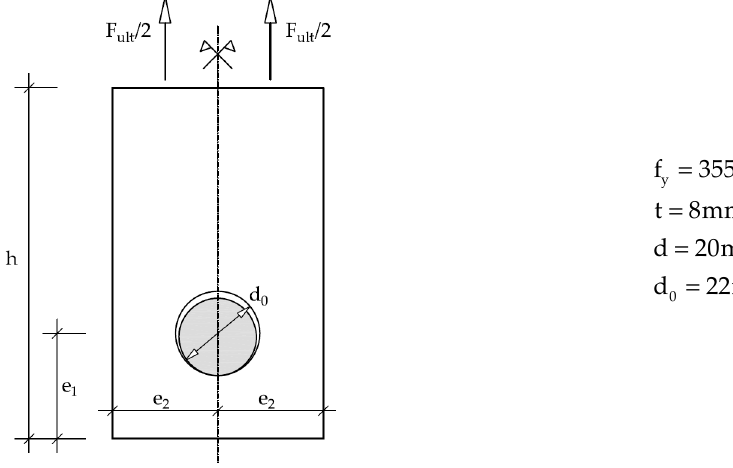
Figure 14. Plate in bearing with bolt and loading situation.